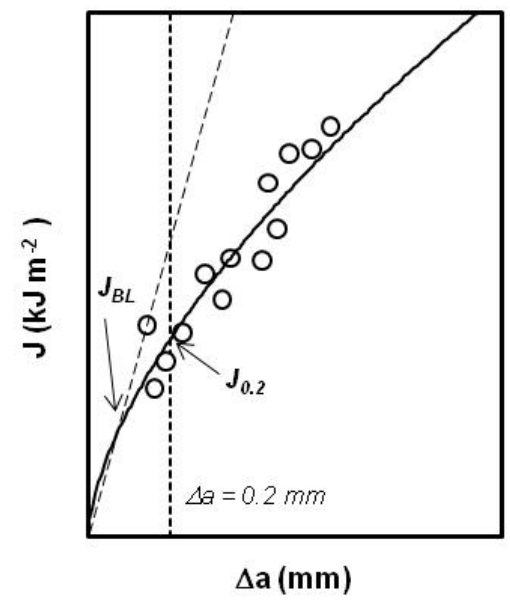
and J from the experimental J-R 0.2 BL